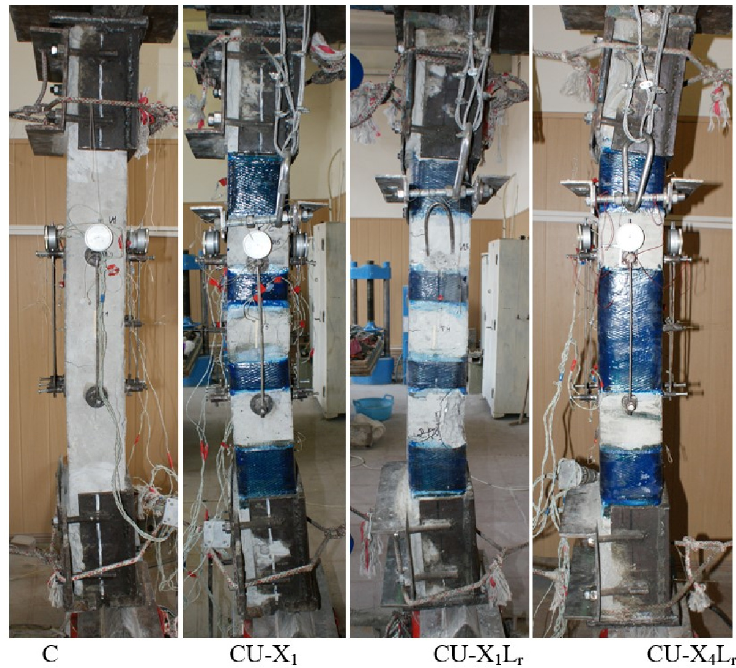
Figure 10. The nature of the destruction of the reference (C) and reinforced (CU) samples with an axial eccentricity of the load application e 0 = 4 cm ( e 0 = 0.32